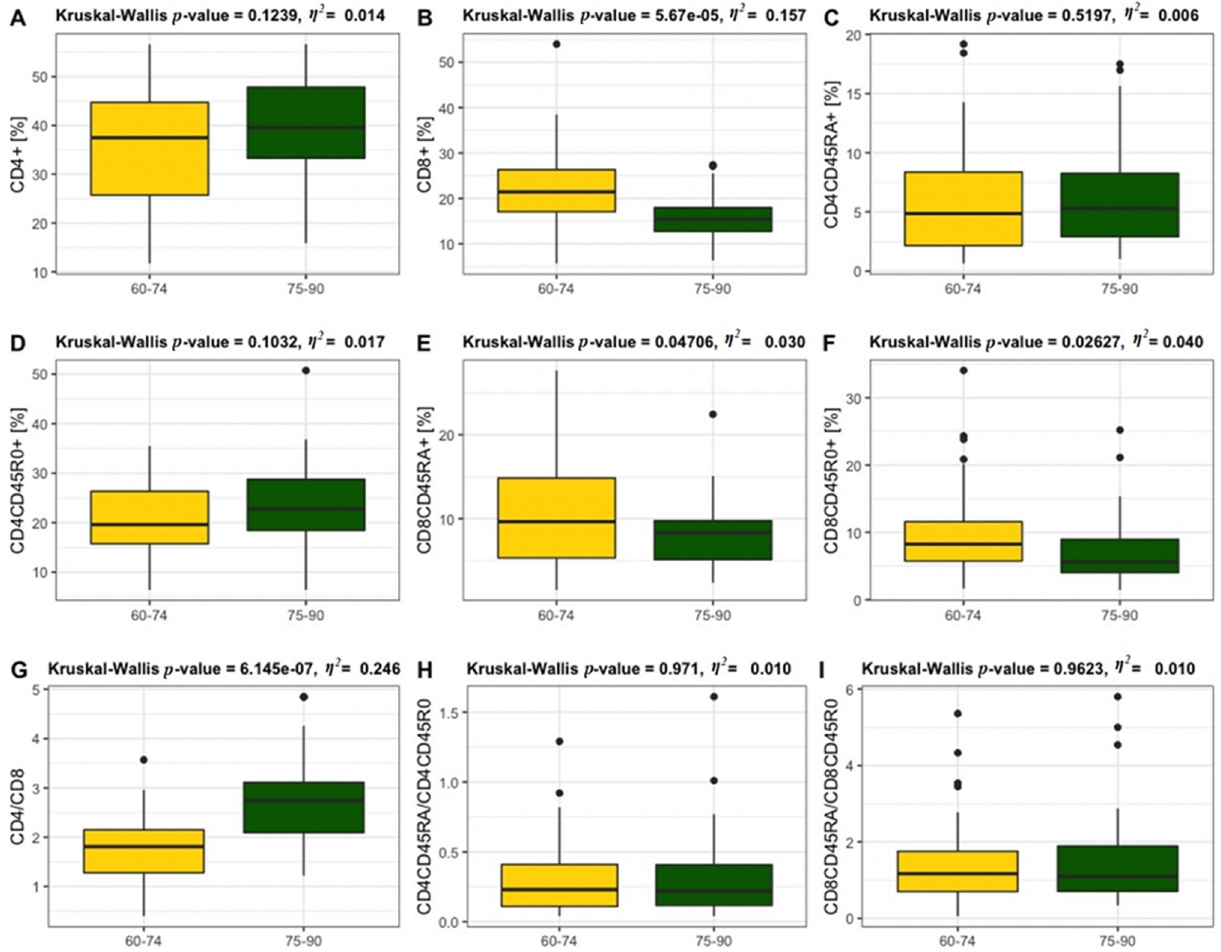
Figure 4. Percentages of total CD4 + ( A ) and CD8 + ( B ) T lymphocytes and the CD4 + naïve ( C ) and CD4 + memory ( D ) and CD8 + naïve ( E ) and CD8 + memory ( F ) T lymphocytes in 60–74 years ( n = 63) of age and 75–90 ( n = 36) years of age and the following ratios: CD4/CD8 ( G ), CD4CD45RA/CD4CD45RO ( H ) and CD8CD45RA/CD8CD45RO ( I ).